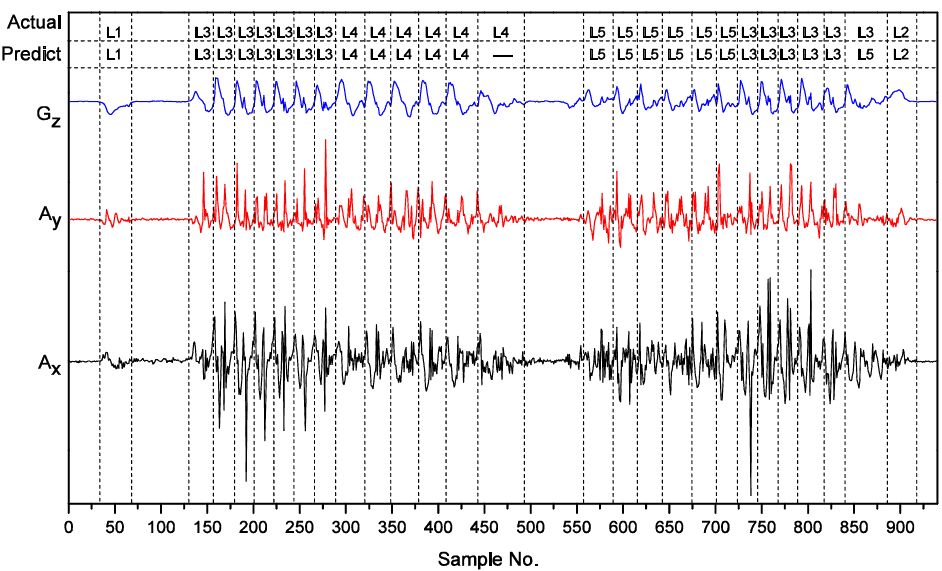
Figure 6. Live detection results of a subject’s serial activities.